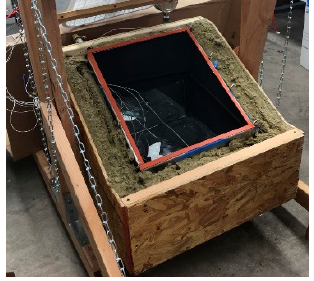
Figure 1. Solar Still: Basin and Insulation.